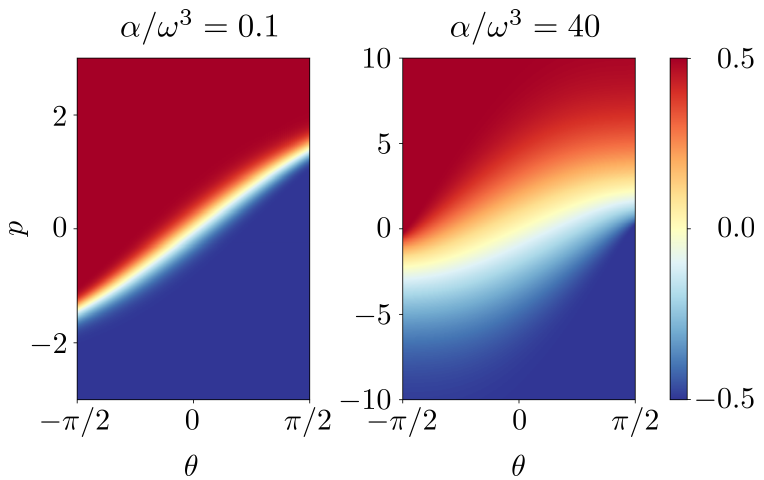
Figure 3: Density plots of ψ ( θ , p ) for α/ω 3 = 0.1 (weak driving) and 40 (strong driving) obtained by numerical solution of Eq. (9) with the boundary conditions